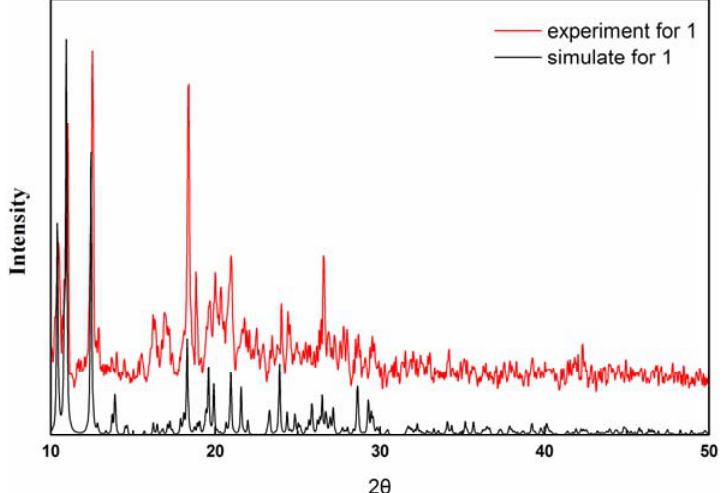
Figure 7. Simulated and experimental XRPD patterns for complex 1